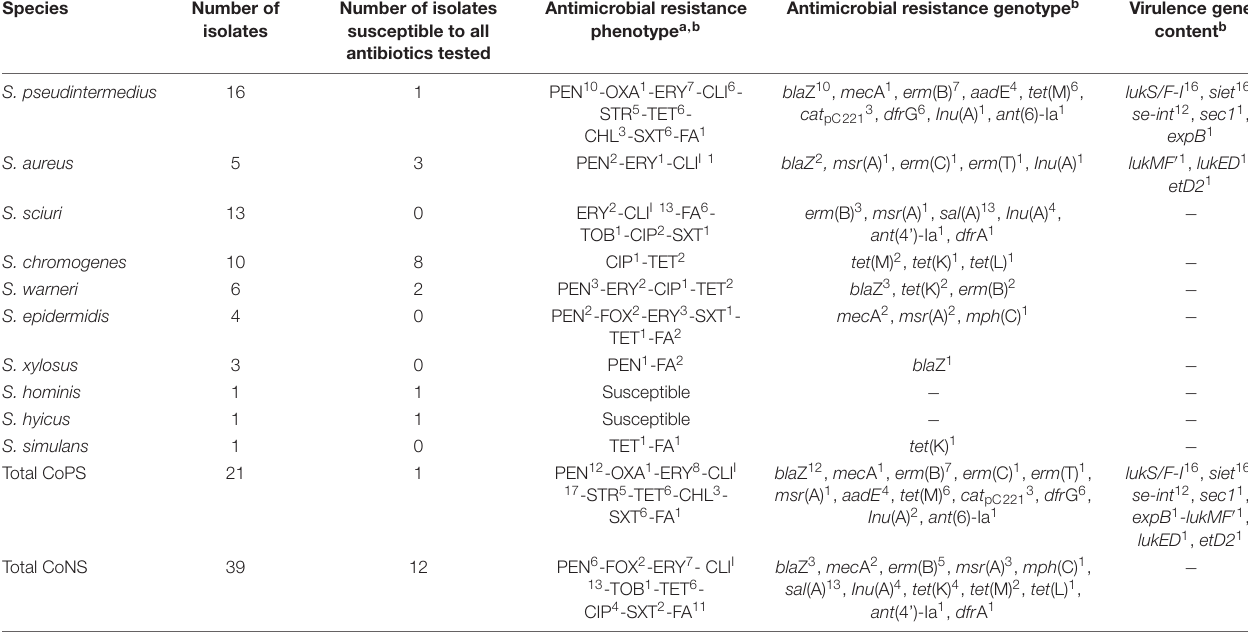
TABLE 6 | Antimicrobial resistance phenotype/genotype and virulence gene content in the 60 BLIS + isolates recovered in this study. Species Number of Number of isolates isolates susceptible to